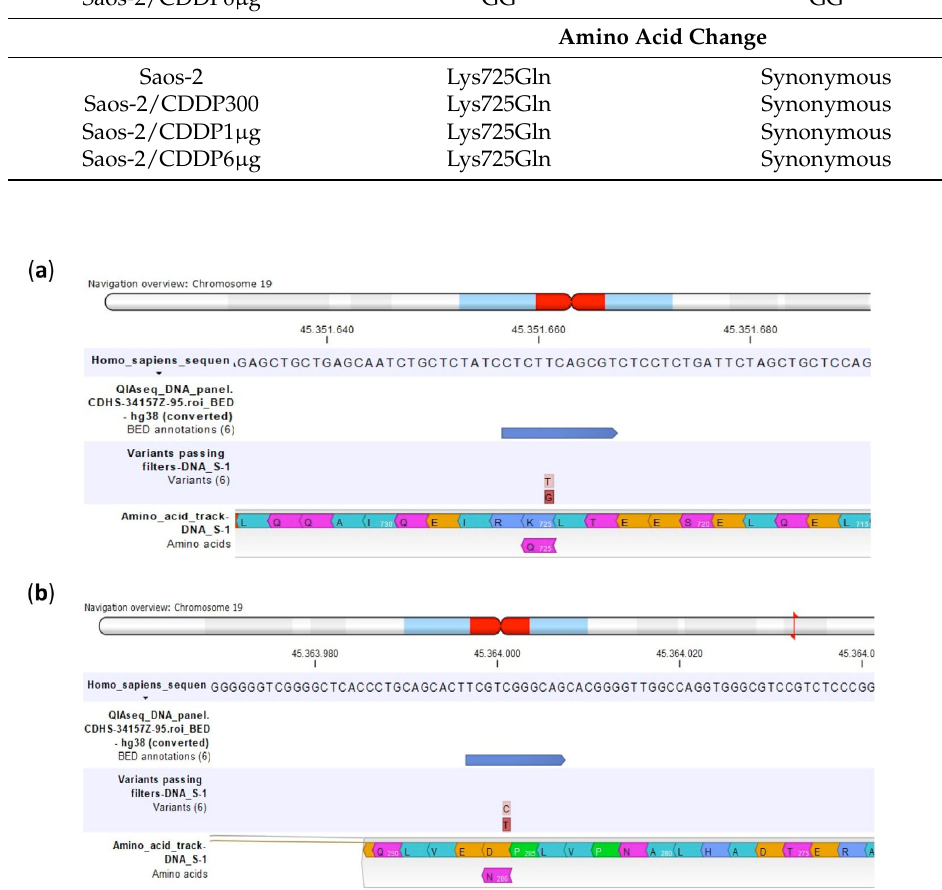
Figure 3. Amino acid changes identified by multimodal targeted next generation sequencing (mmNGS) in the U ‐ 2OS cell line for the ERCC2 rs13181 ( a ) and ERCC2 rs1799793 ( b ). Amino acids are colored by the CLC Genomics Workbench (GWB) according to the Rasmol color scheme. For ERCC2 rs13181, the genotype of the detected polymorphism was heterozygous variant GT in the sensitive and the two Saos-2 resistant variants with lower resistance levels, while in the Saos-2/CDDP6 µ g variant the genotype changed to homozygous variant GG (Figure 4). The same situation occurred for ERCC1 rs11615, which was heterozygous variant GA in the sensitive cell line and the two resistant variants with lower resistance levels, whereas homozygous variant GG in Saos-2/CDDP6 µ g (Figure 5). Different to the ERCC2 rs13181 variant, which caused an amino acid change from Lys to Gln, no amino acid changes were revealed by the CLC GWB analysis for the synonymous ERCC1 rs11615 variant (Figure Table 3. DNA single nucleotide polymorphisms with genotype and amino acid changes in Saos ‐ 2 cisplatin (CDDP) ‐ resistant variants compared to their parental cell line, which were identified by both multimodal targeted next generation sequencing (mmNGS) and TaqMan genotyping.